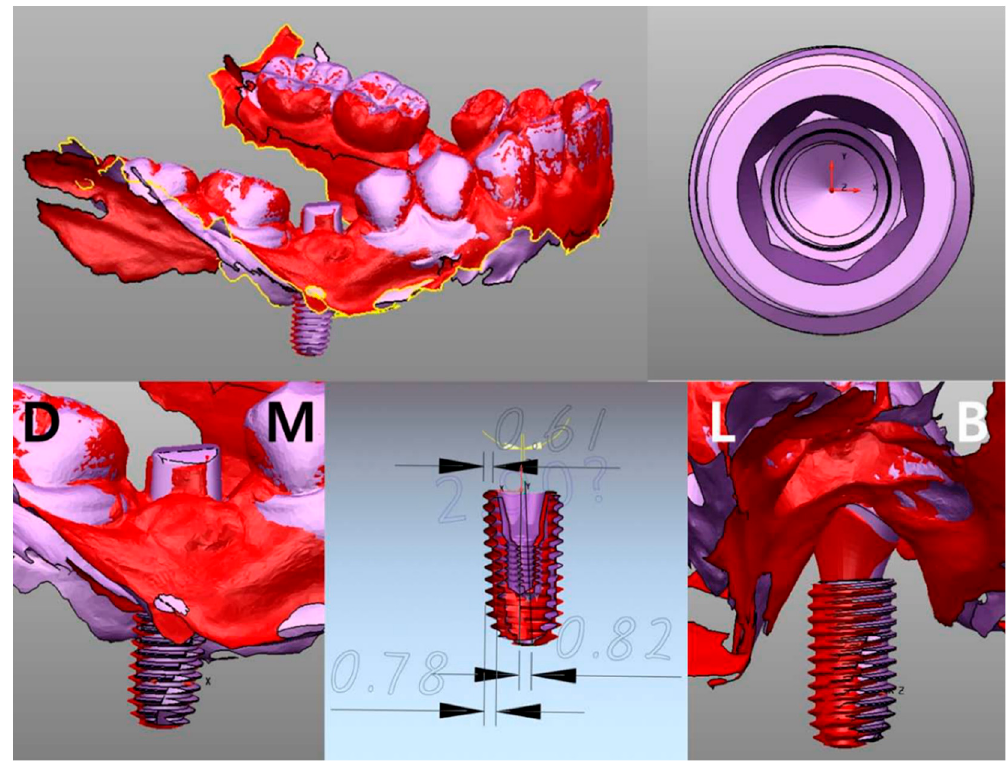
Figure 6. Displacement measurement by indirect method. The planned position (purple) and the placed position (red) are superimposed.